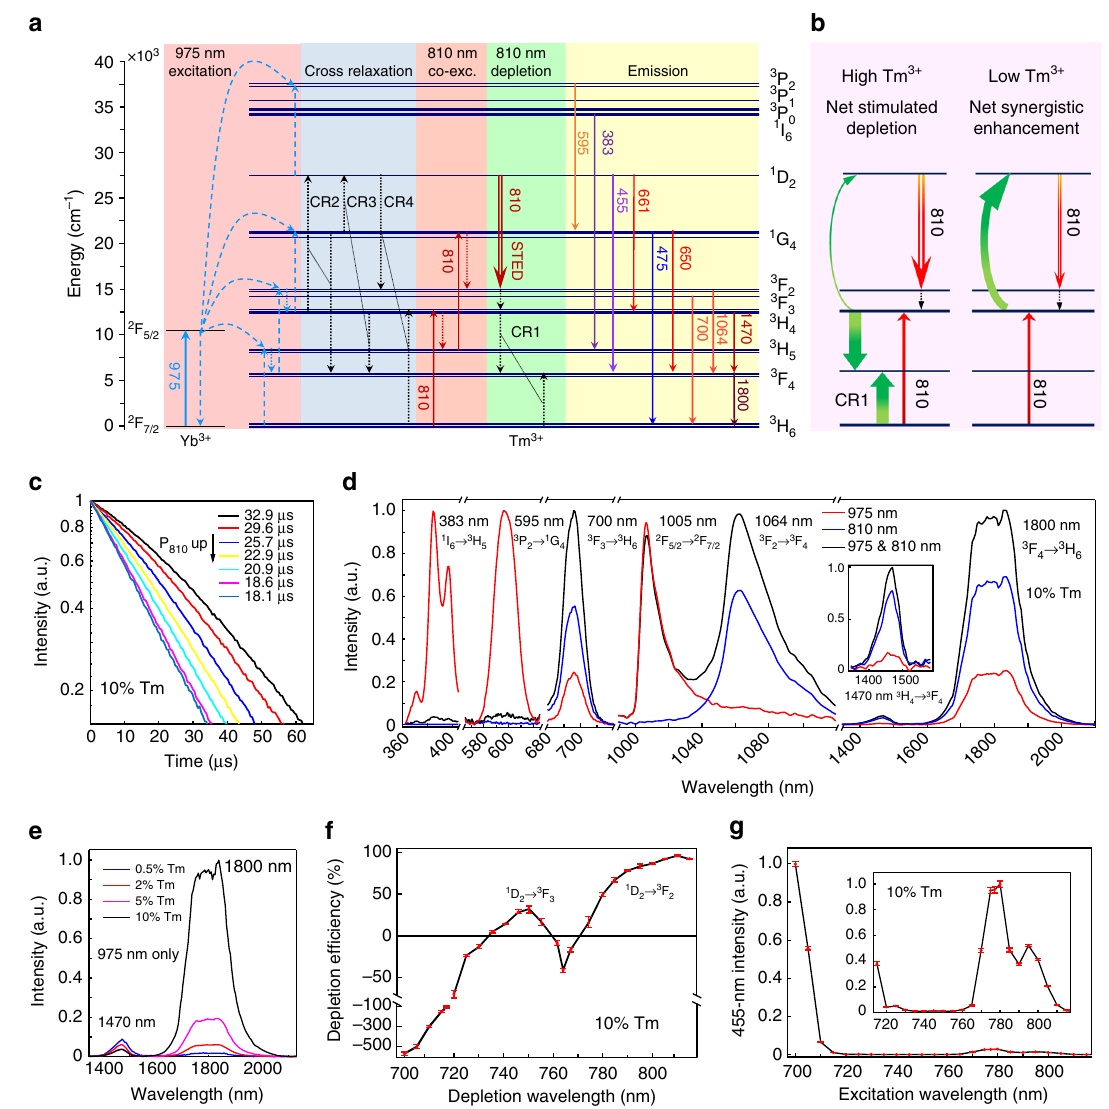
Fig. 2 Optical depletion mechanism of the 455-nm upconversion luminescence in NaYF 4 :18% Yb 3+ , 10% Tm 3+ nanoparticles. a Proposed optical emission depletion mechanism of the 455-nm upconversion band of Tm 3+ of NaYF 4 :18% Yb 3+ , 10% Tm 3+ nanoparticles. b Schematics of net stimulated depletion (left) and net synergistic enhancement (right) induced by 810-nm irradiation in high and low Tm 3+ -doped UCNPs, respectively. c Decay lifetimes of the 455-nm emission of NaYF 4 :18% Yb 3+ , 10% Tm 3+ UCNPs at different power densities (Supplementary Table 1) of the depleting 810-nm laser. d The intensity change of different emission bands of NaYF 4 :18% Yb 3+ , 10% Tm 3+ UCNPs under 975-nm excitation with/without 810-nm irradiation. The spectra were individually normalized in each spectral range, including 360 – 400, 570 – 615, 680 – 715, 980 – 1140, and 1300 – 2100 nm, separated by cutoff marks, in order to clearly display the relative intensity changes of different emission bands with and without the 810-nm irradiation. e The Tm 3+ doping concentration-dependent 1470-nm and 1800-nm downconversion emission spectra of NaYF 4 :18% Yb 3+ , x% Tm 3+ UCNPs ( λ exc = 975 nm). f Dependence (cid:1) (cid:3) (cid:1) I 975 & STED = I 975 of 455-nm depletion ef fi ciency (DE, I 975 )) of NaYF 4 :18% Yb 3+ , 10% Tm 3+ on the depletion laser wavelength ( Δ λ = 4 nm) ranging from 455 455 455 700 to 815 nm. Negative depletion ef fi ciency represents emission enhancement. The intensity of the 975-nm excitation laser and the depletion laser were kept at 700 kW cm − 2 and 17.7 MW cm − 2 , respectively. g The excitation spectrum for the 455-nm emission of NaYF 4 :18% Yb 3+ , 10% Tm 3+ solely excited by the depletion laser with wavelength ranging from 700 to 815 nm; the inset is an enlarged view. Error bars represent ± 1